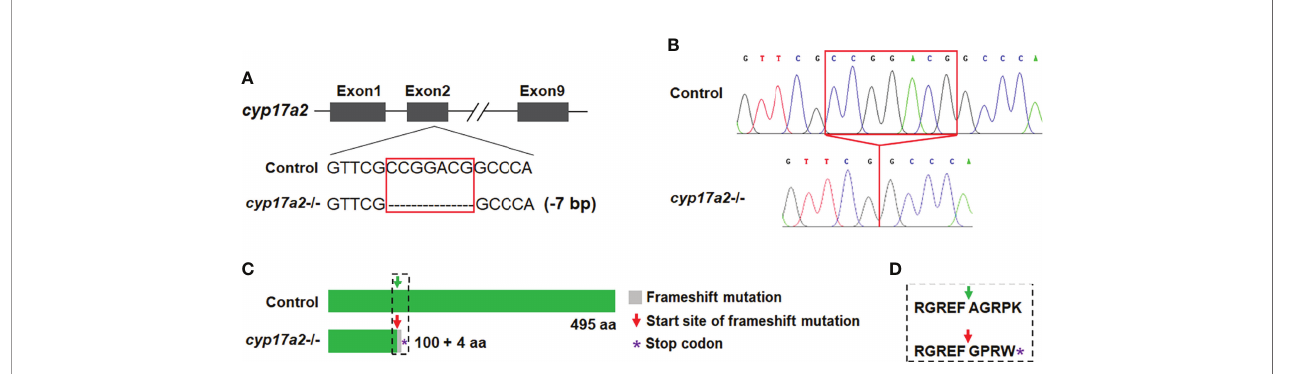
FIGURE 1 | Deletion of cyp17a2 in zebra fi sh by CRISPR/Cas9. (A) The gRNA target site of cyp17a2 in the second exon. cyp17a2 -null zebra fi sh with 7 base pairs deletion was obtained. (B) The representative chromatograms of the DNA sequences of control fi sh and cyp17a2 -/- zebra fi sh, as evidenced by DNA sequencing of the PCR ampli fi ed DNA fragments using the genome DNA or cDNA as the template. The red squares in panel A and B indicate the 7 base pairs which have been deleted in cyp17a2 -/- fi sh. (C) The predicted Cyp17a2 protein and mutant protein of cyp17a2 -/- fi sh. The peptides of mutant Cyp17a2 identical to control Cyp17a2 protein are shown in green, the frameshift mutation is shown in gray. The premature stop codon is indicated with purple asterisk in panel (C) aa, amino acid. The amino acids before and after the start site of frameshift mutation in cyp17a2 -/- fi sh and the corresponding area in the control fi sh is highlighted in dotted square and the detailed information is shown in panel (D) . (D) The detailed amino acid sequence of the dotted square in panel (C) .